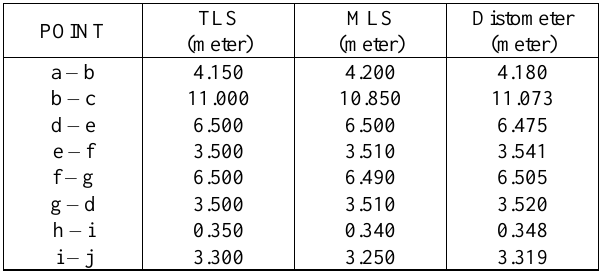
Table 1. Result of distance measurement